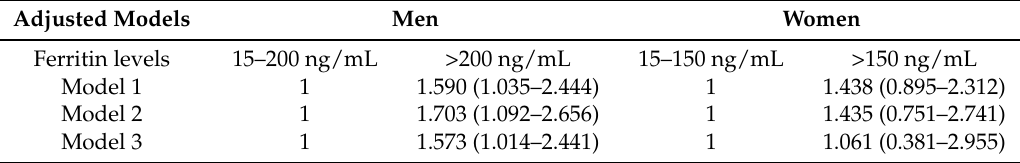
Table 3. Odds ratios for chronic kidney disease according to ferritin